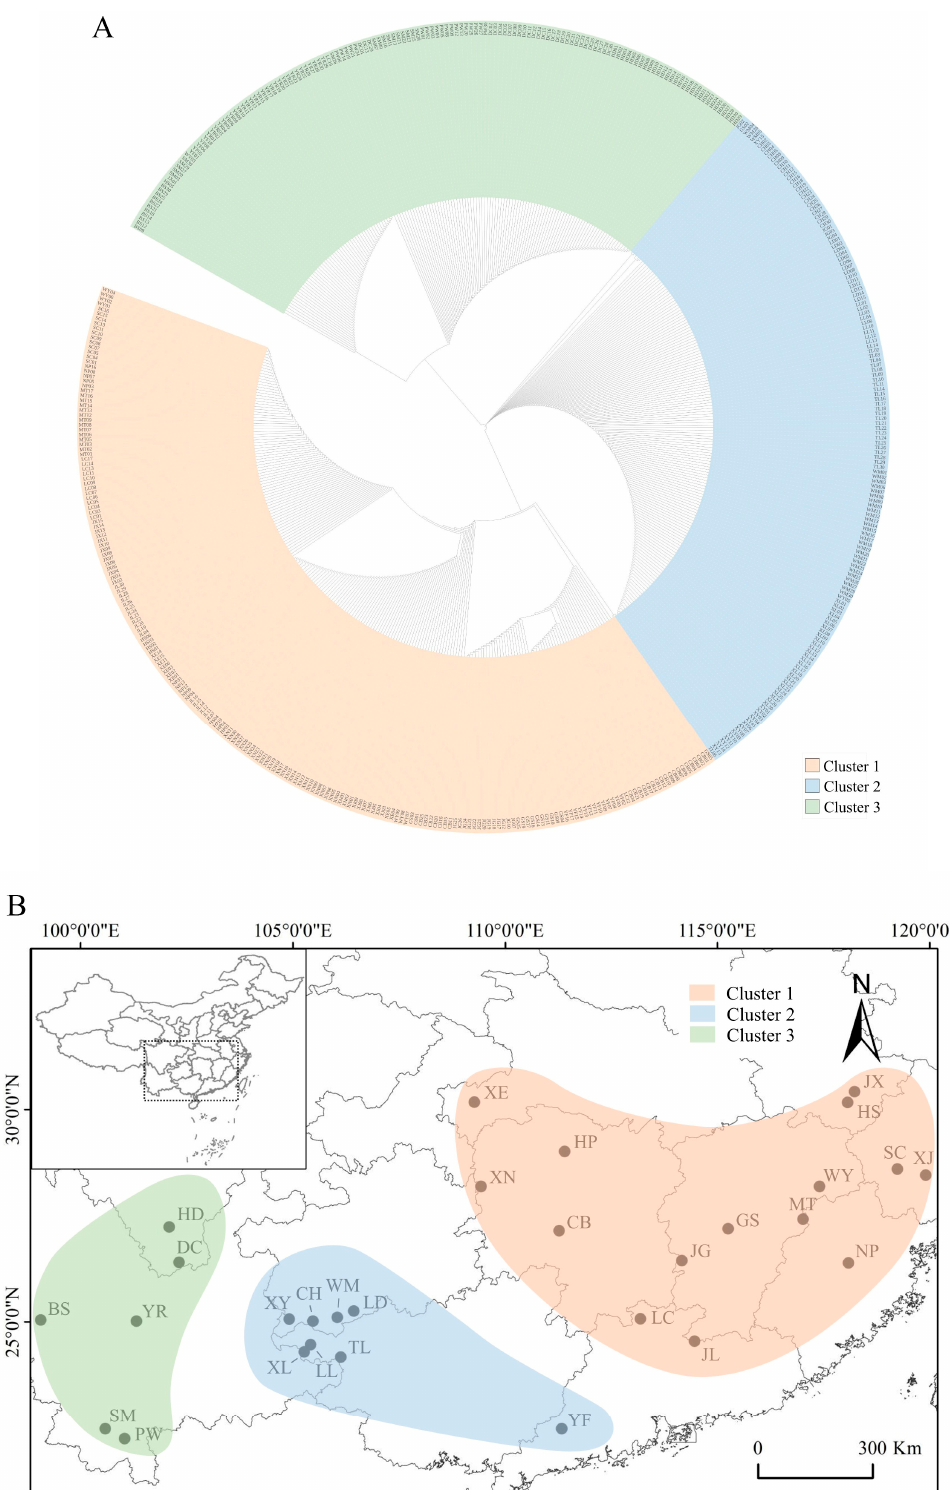
Figure 4. Phylogenetic relationships and geographic clusters of 29 populations. ( A ) is the phylogenetic relationships among 500 individuals derived from mtDNA markers, showing three clusters. ( B ) is the three regions of populations corresponding to the three clusters in the top figure.